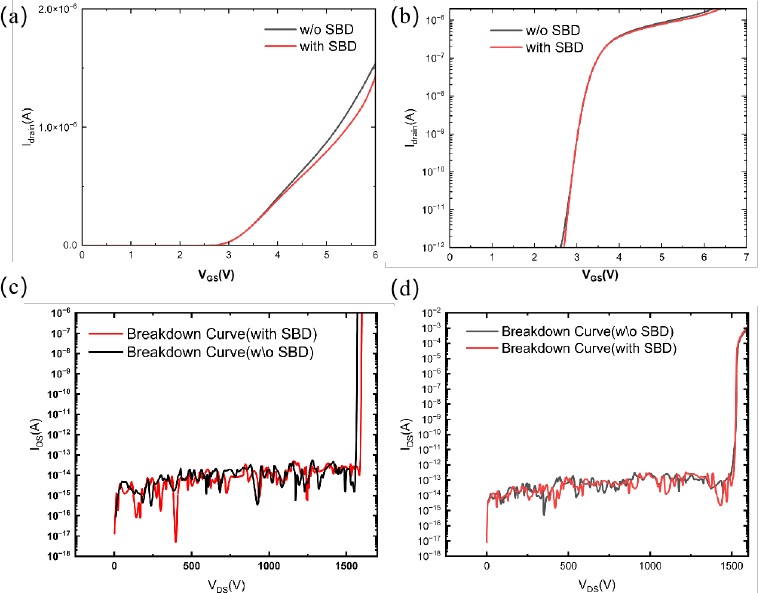
Figure 2. ( a ) Transfer (I d -V g ) of TED-MOS SiC, with or without the SBD structure, under the condition of V d = 0.1 V on a linear scale; ( b ) Transfer (I d -V g ) of TED-MOS SiC, with or without the SBD structure, under the condition of Vd = 0.1 V on a log scale; ( c ) The reverse breakdown simulation under the condition of V g = − 5 V ( d ) The forward breakdown simulation under the condition of V g = 0 V.